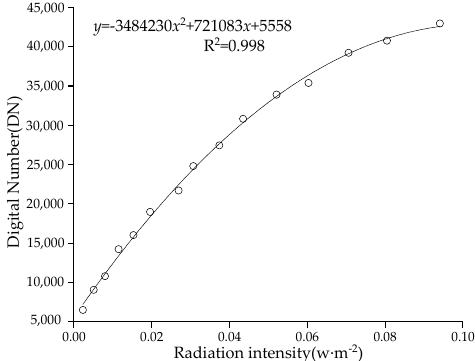
Figure 11. The relationship between the DN of the image display and the 668 nm red light radiation intensity.